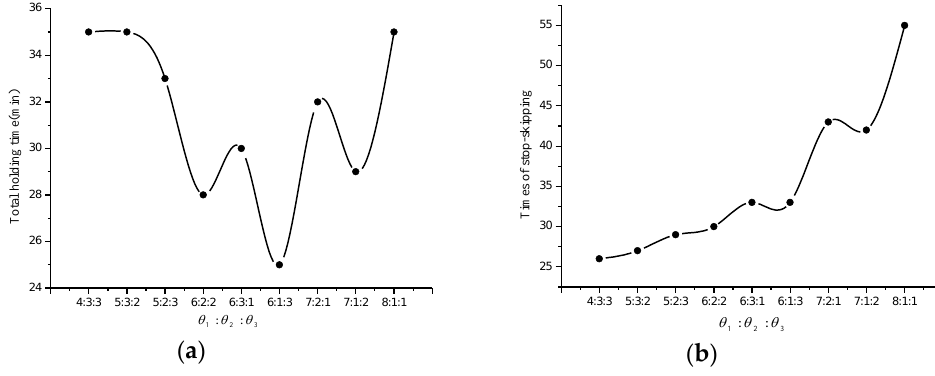
Figure 4. Sensitivity analysis of weighting factors: ( a ) Total holding time varies with the weight proportion; ( b ) Times of stop-skipping varies with the weight proportion.